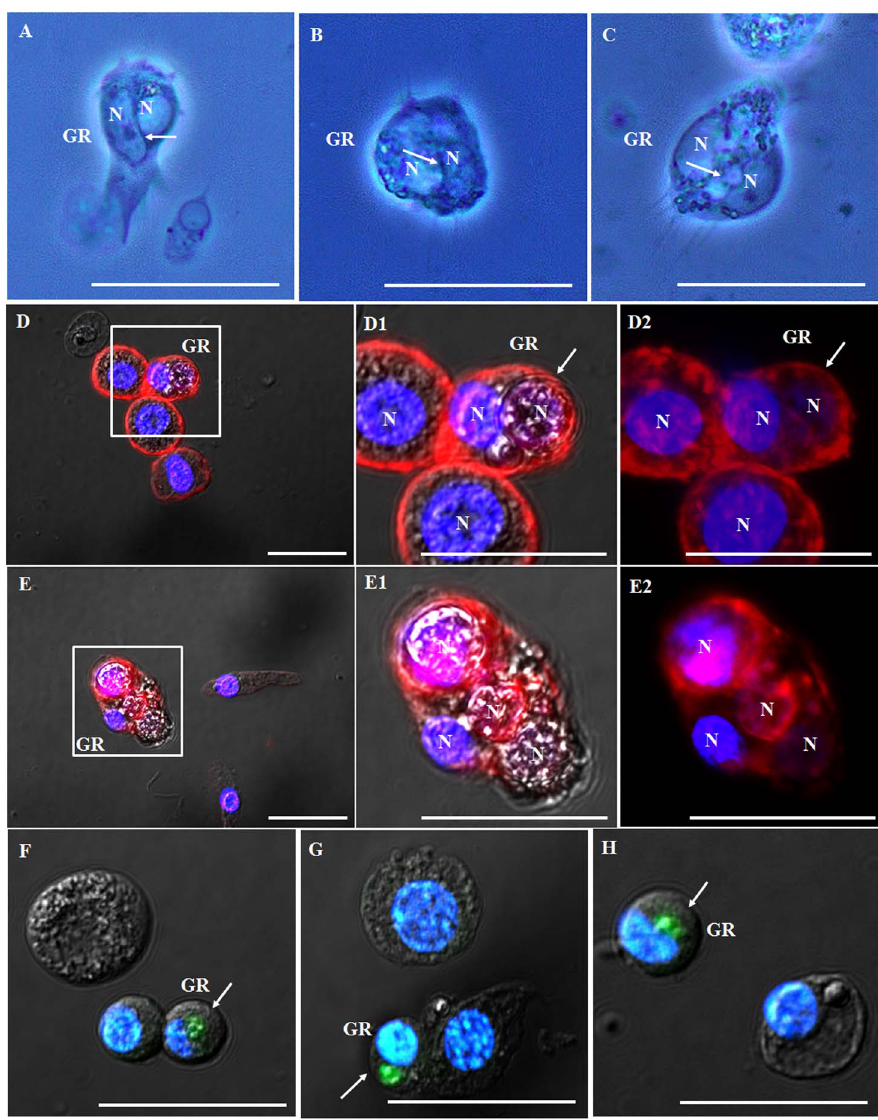
Figure 4. Complete internalization of large foreign particles by granulocytes. Hemocytes (average size 20.1 m m, n=30) from the Stag Beetle Lucanus maculifemoratus ( Coleoptera : Lucanidae) were injected into the hemocoel. At 12 h post injection, highly polymorphic glittering vacuoles were generated in the granulocytes. (A through C) The granulocytes engulfed and phagocytosed foreign cells and showed classic structures of phagocytosis (cell-in-cell invasion; a crescent-shaped nuclei) indicated by white arrow. (D through D2) Analysis by confocal microscopy demonstrated a complete internalization of hemocytes from L . maculifemoratus within the granulocytes. In some cases, one, or two, even three foreign hemocytes were phagocytized by the granulocytes (E through E2). D1, D2, E1, and E2 indicate a higher magnification of regions in inset of panel D and E. (F through H) GFP CellTracker dye labeled hemocytes (indicated by white arrow) from L . maculifemoratus were completely internalized by the granulocytes. GR, granulocytes; N, nuclei, Scale bar=20 m